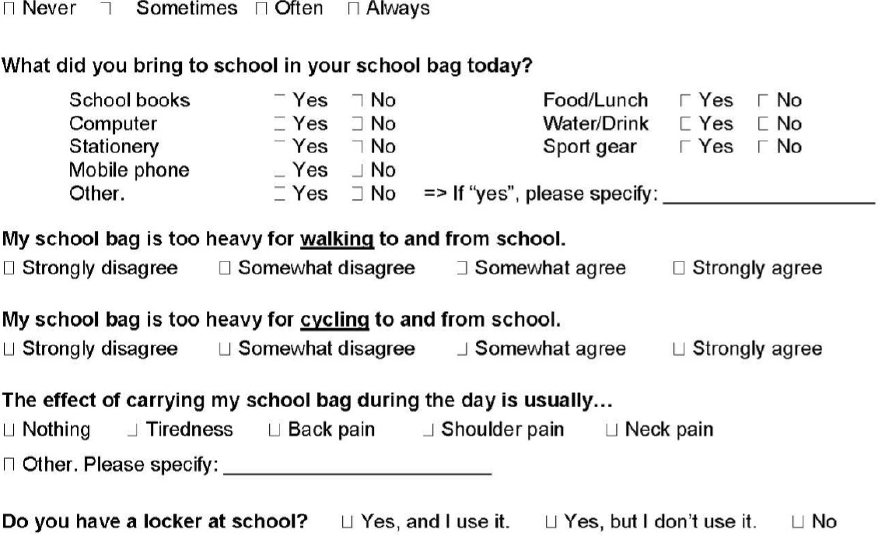
Figure 1. School bag questionnaire items. Notes: This figure does not contain images used in the study questionnaire as examples of different school bag types and different ways of carrying a school bag. In the BEATS Natural Experiment, the response categories to the question about a locker at school were ‘Yes, and I use it’, ‘Yes, but I don’t use it’, ‘No, but I want one’ and ‘No, and I don’t want one’ with the last two response categories recoded as ‘No’ for the analysis reported in this